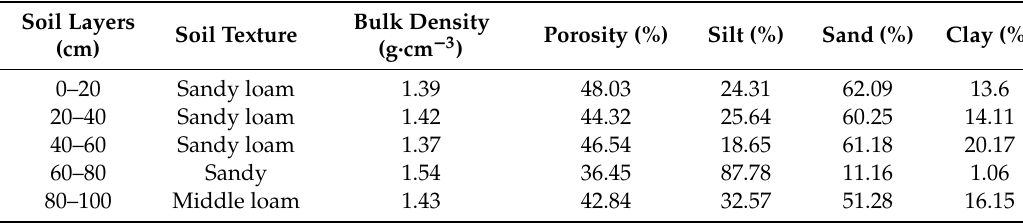
Table 1. Soil physical properties in the experimental area.